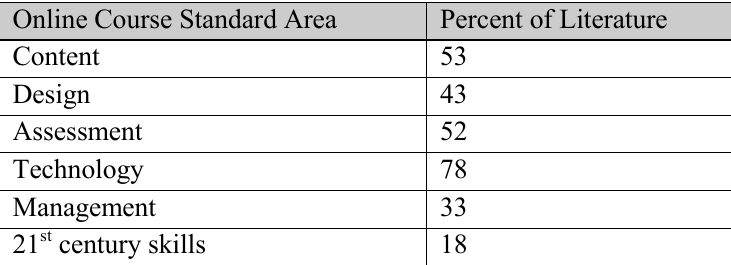
Percentage of Literature about Online Course Standard